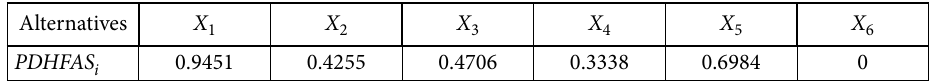
, the optimal alternative is X